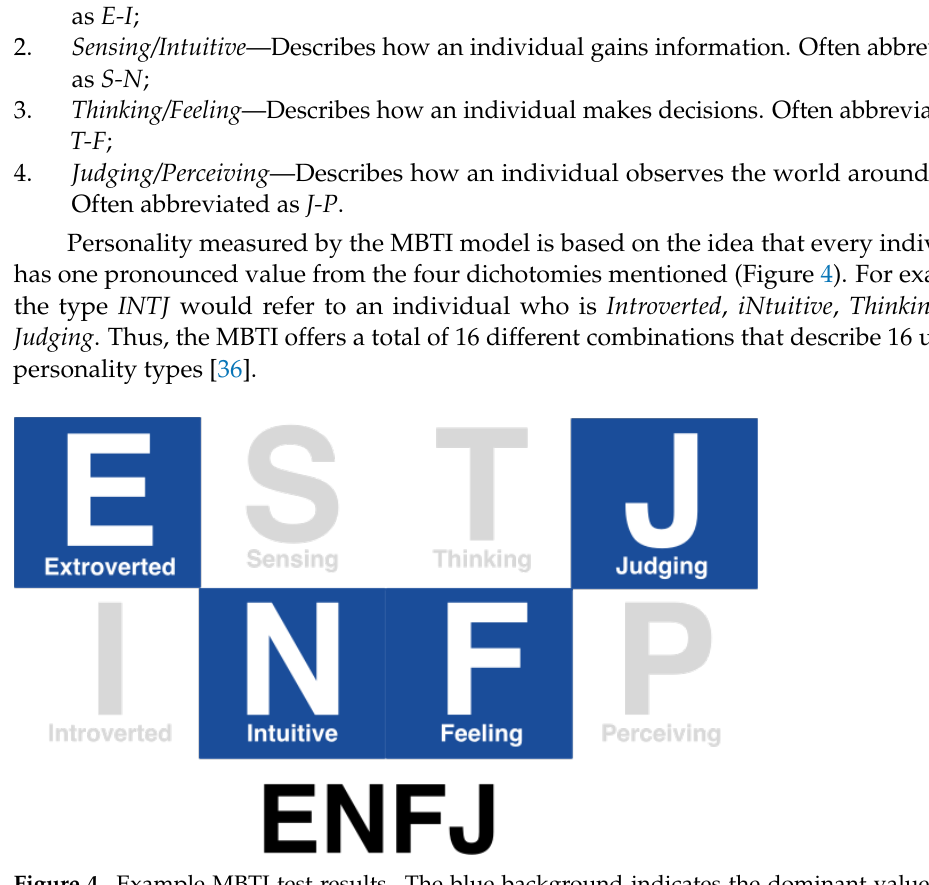
Figure 4. Example MBTI test results. The blue background indicates the dominant value of the